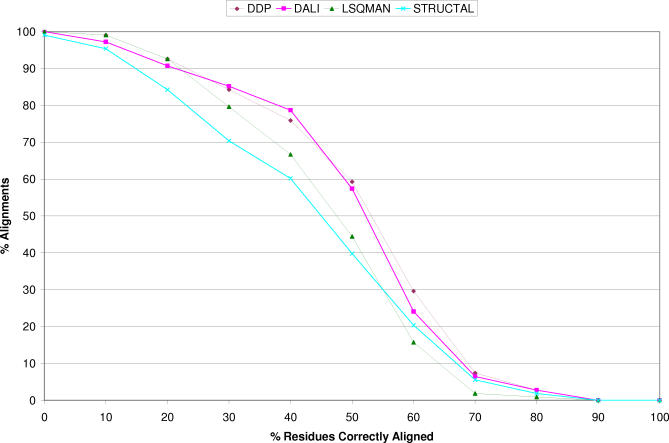
Graph Showing How the Alignments of Each Method Compared with Manually Validated BAliBASE AlignmentsThe higher the curve (or the curve with the greatest area underneath) represents the method that most agrees with the manually curated BAliBASE alignments.